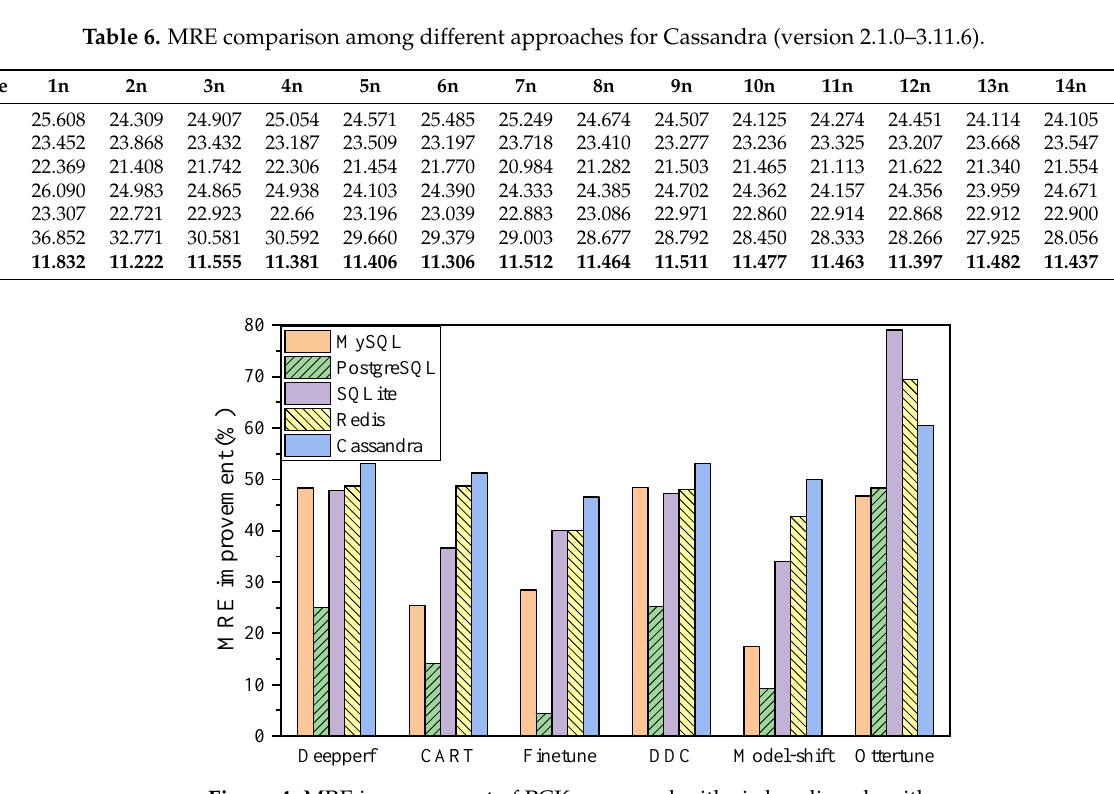
Figure 4. MRE improvement of PCK compared with six baseline